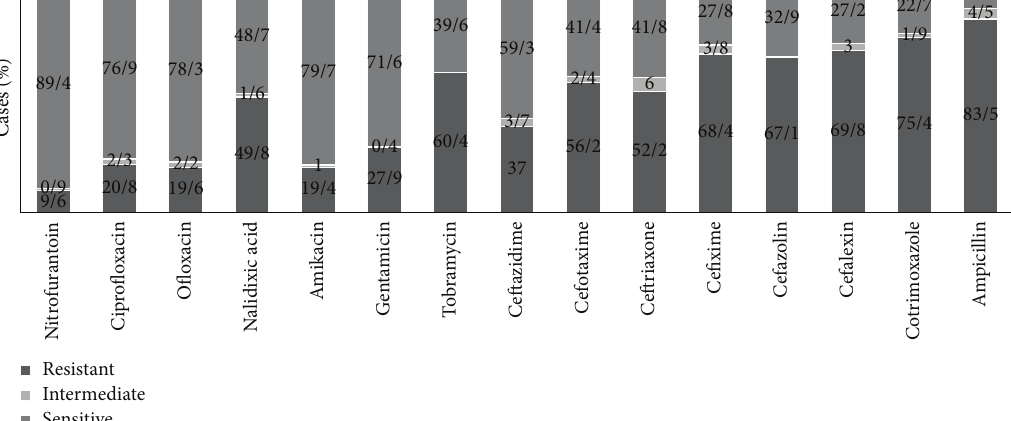
Figure 2: E. coli sensitivity and resistance pattern of bacteria causing UTI to antibiotics.